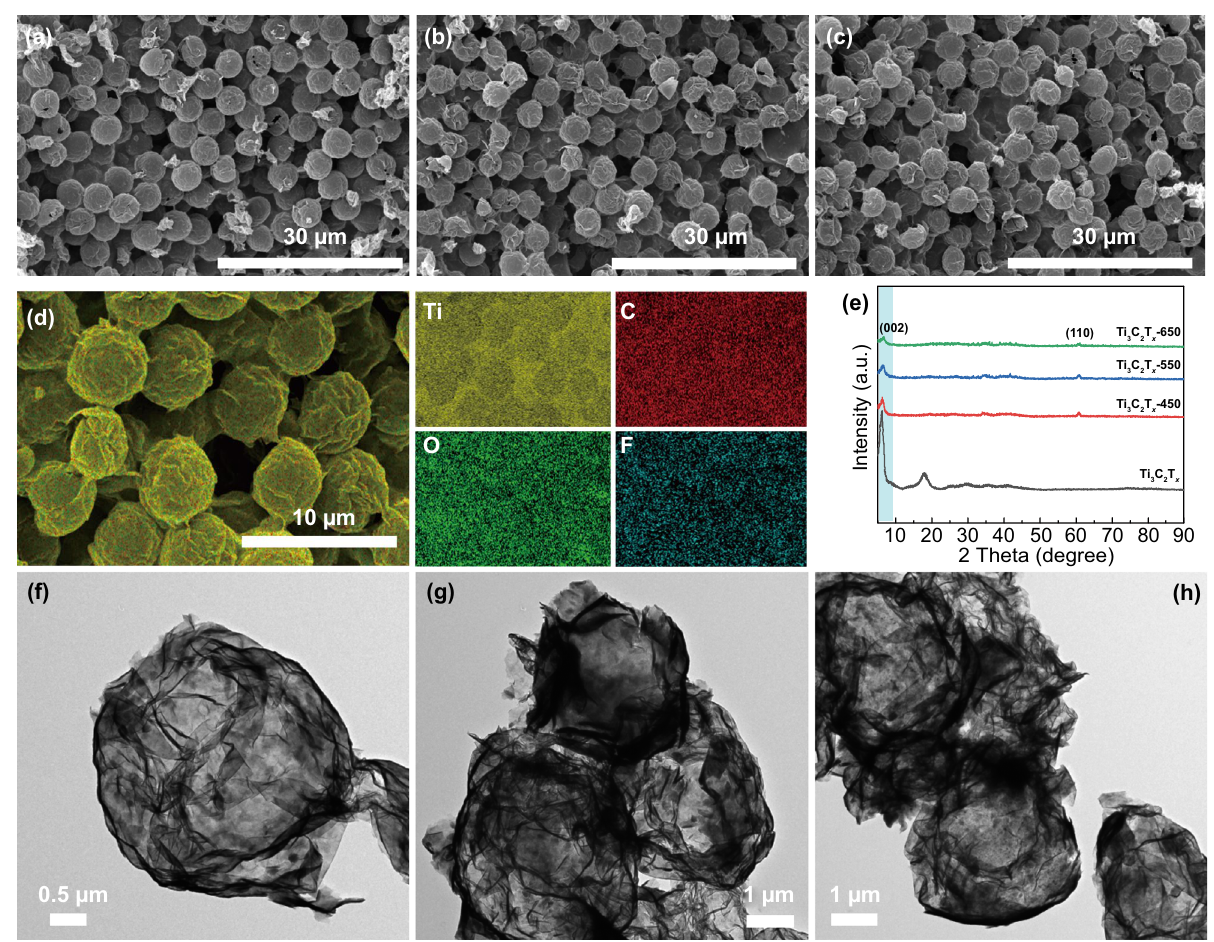
Fig. 1 SEM images for a Ti 3 C 2 T x ‑450, b Ti 3 C 2 T x ‑550, and c Ti 3 C 2 T x ‑650; d the corresponding elemental mapping of Ti 3 C 2 T x ‑650; e XRD Pat‑ terns of Ti 3 C 2 T x and Ti 3 C 2 T x hollow spheres; TEM images for f Ti 3 C 2 T x ‑450, g Ti 3 C 2 T x ‑550, and h Ti 3 C 2 T x